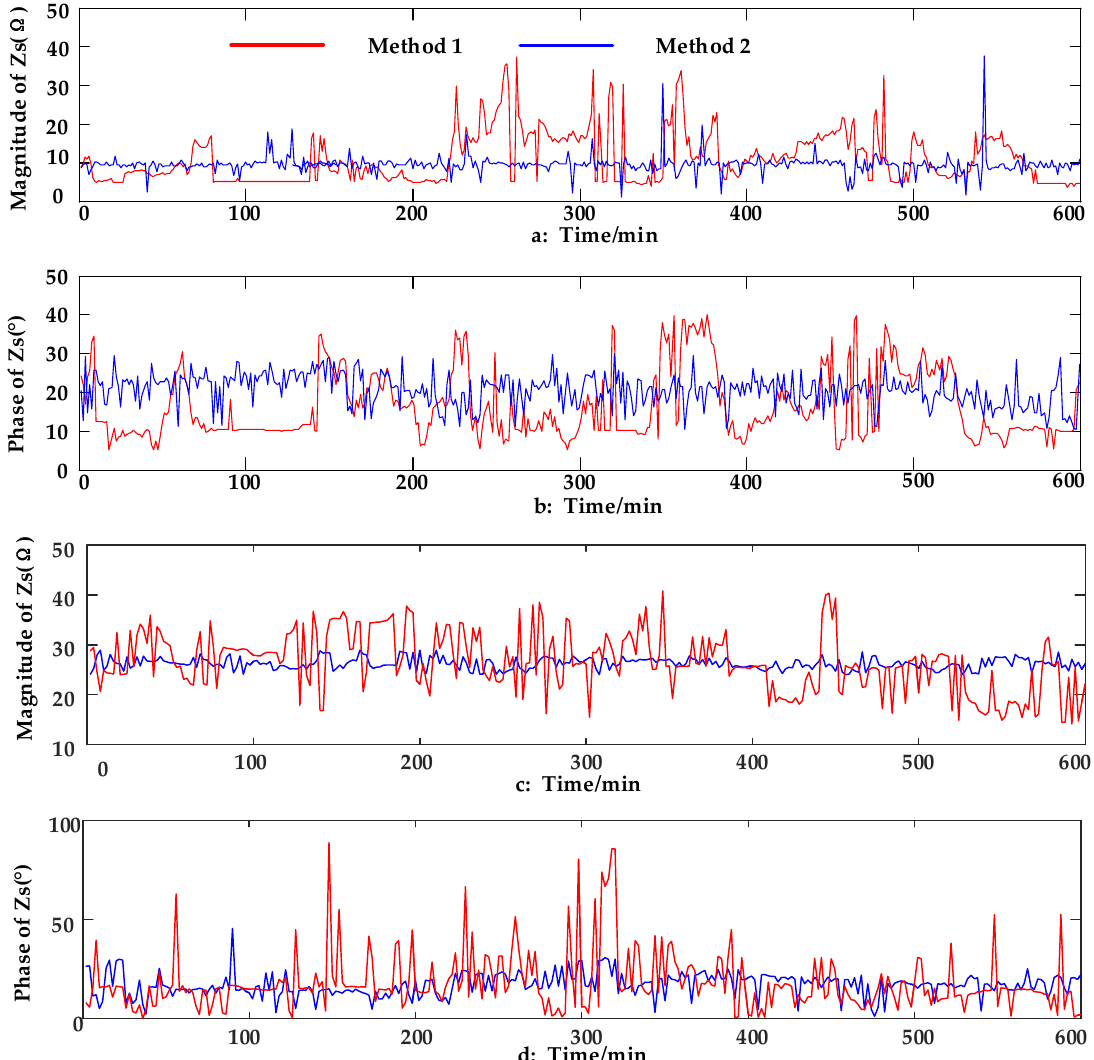
Figure 9. The magnitude and phase of utility harmonic impedance: ( a ) Magnitude of 3rd harmonic impedance; ( b ) phase of 3rd harmonic impedance; ( c ) magnitude of 11th harmonic impedance; ( d ) phase of 11th harmonic impedance.